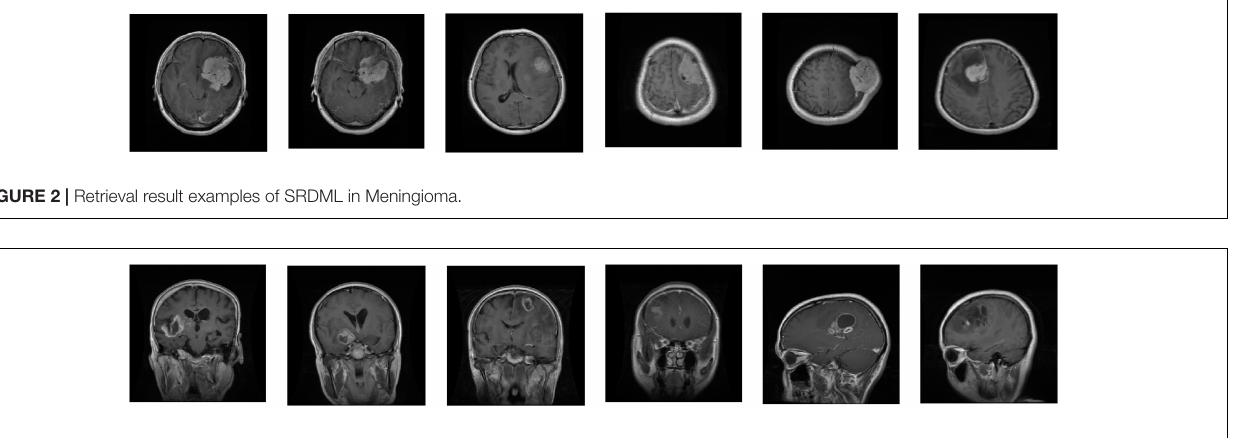
FIGURE 3 | Retrieval result examples of SRDML in